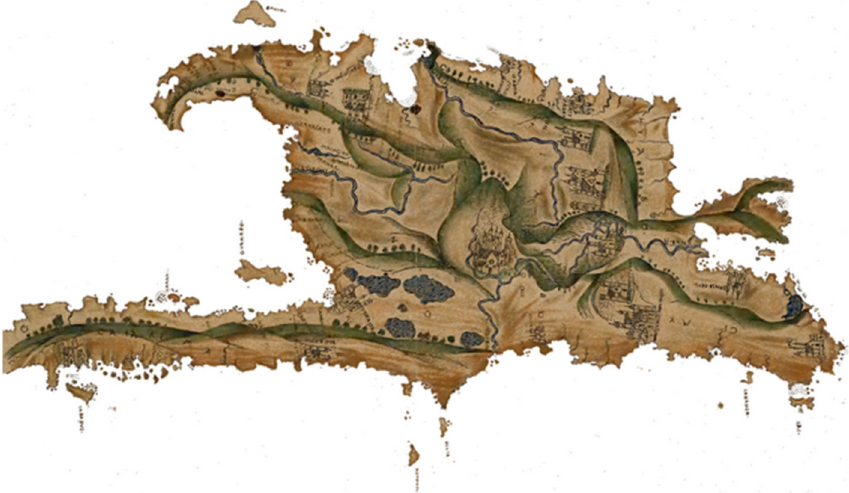
Figure 3. The villa of Salvaleón de Higüey is marked by the San Dionisio Sanctuary at the southeastern-most edge of the island. Map of Hispaniola by Andrés Morales , in Peter Martyr, De Orve Novo Decades , 1516. From Emilio Rodríguez Demorizi 1979, comp. Mapas y planos de Santo Domingo (1979), p. 5. Copyright: Editora Taller.